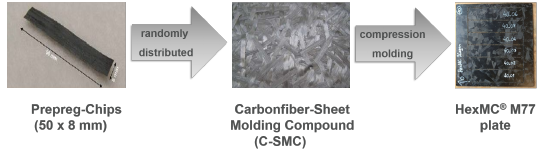
Figure 2. C-SMC production process (reprinted from